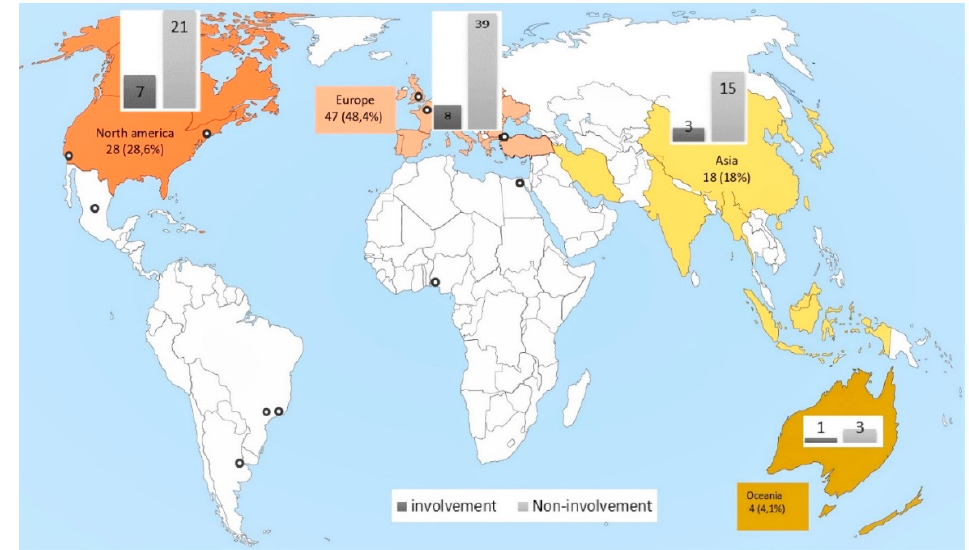
Figure 2. Distribution of included articles and interventions with involvement according to continent of publication.